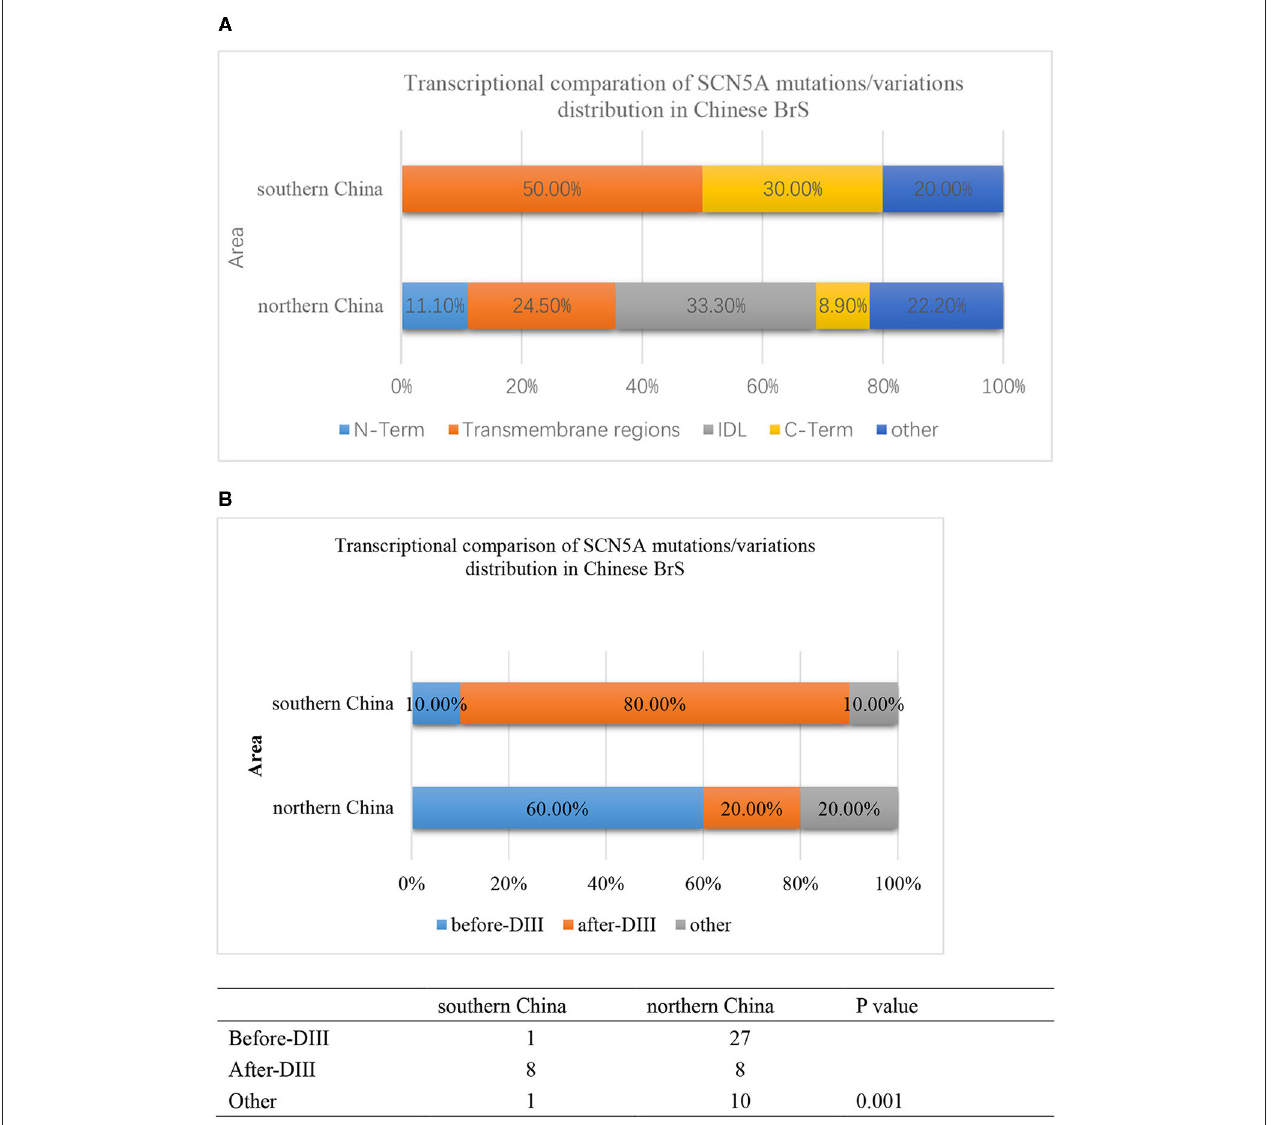
FIGURE 4 | (A) The transcriptional comparison of the SCN5A mutation/variation distribution between southern China and northern China, which was distinguished by N-term, Transmembrane, IDL, C-term, and other parts of the SCN5A gene. The light blue bar represents N-terminus. The orange bar represents transmembrane regions. The gray bar represents the IDL region. The yellow bar represents the C-terminus. The deep blue bar represents other regions. (B) The transcriptional comparison of the SCN5A mutation/variation distribution between southern China and northern China, which was distinguished by before-DIII, after-DIII, and other parts of the SCN5A gene. The blue bar represents before-DIII parts. The orange bar represents after-DIII parts. The gray bar represents other